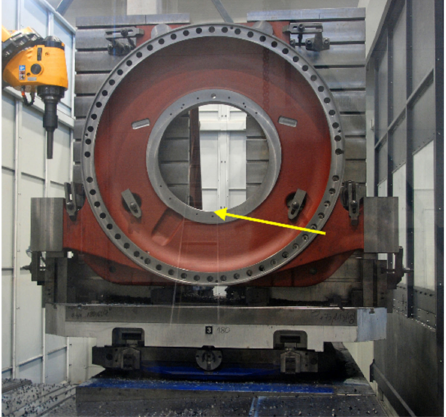
Figure 1. View of a large-size workpiece mounted on the table of the WHN 13-15 CNC machine. The roughness measurement point is indicated.